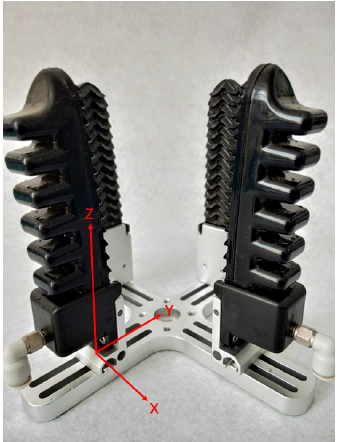
Figure 4. The proposed soft landing gear.